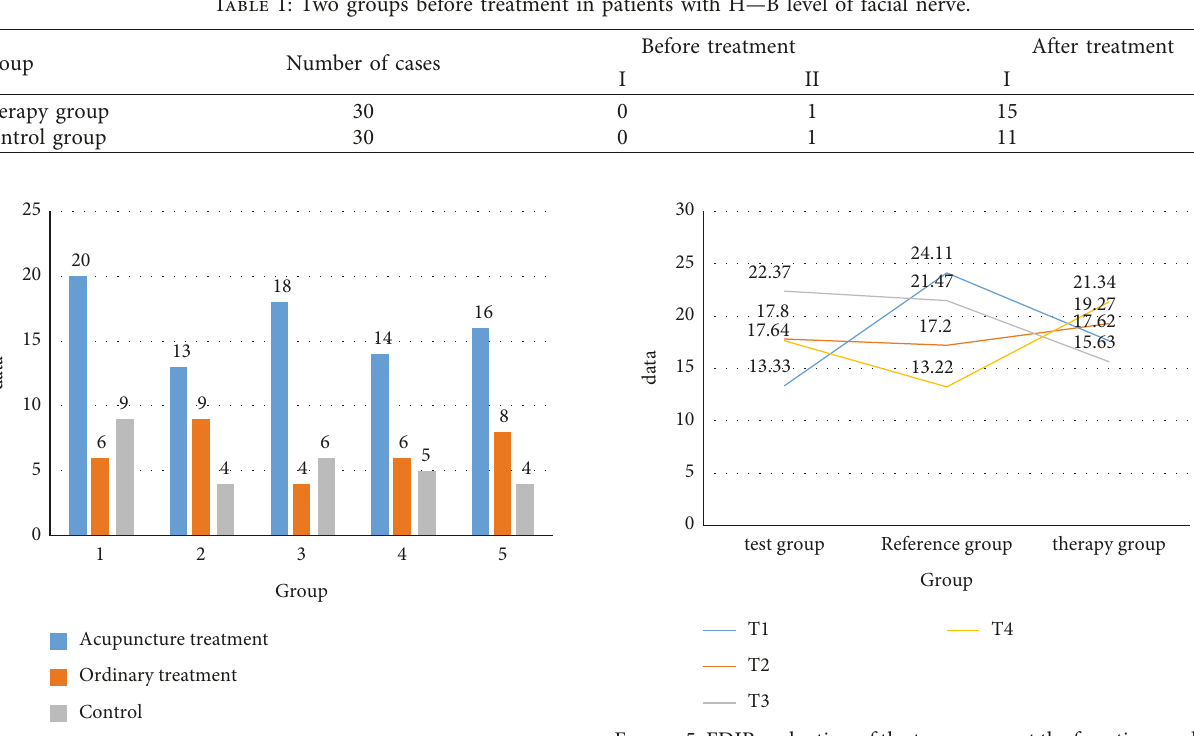
Figure 3: Comparison of different treatment methods for patients with facial paralysis.